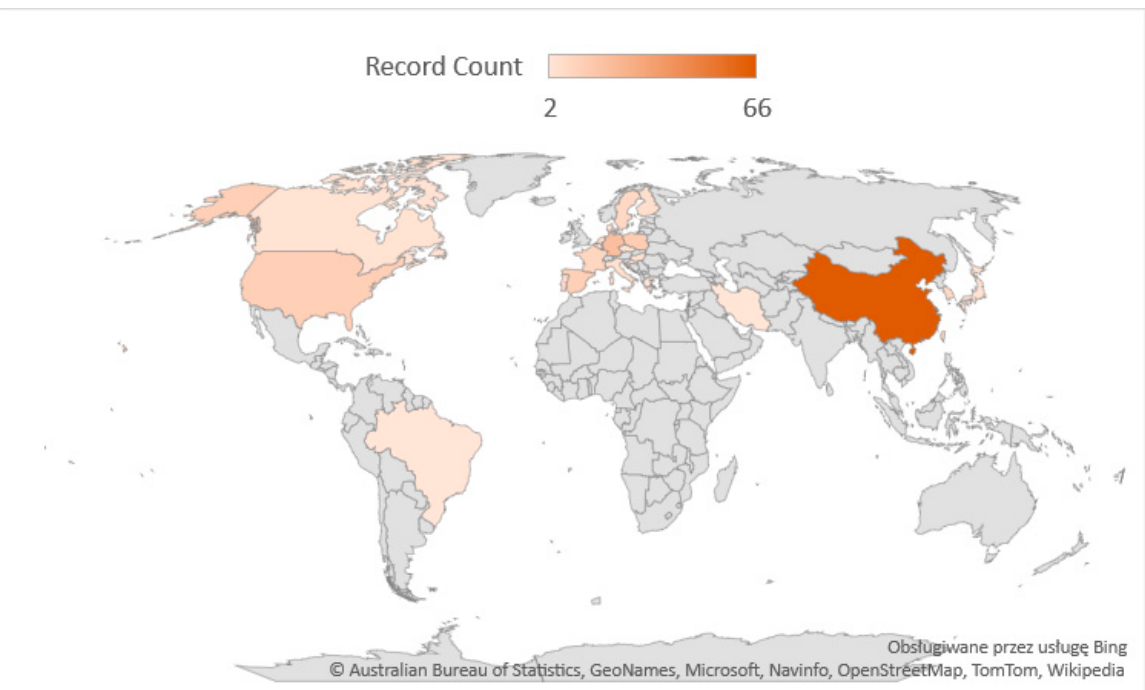
Figure 8. Scientific contribution by country and geographic region.